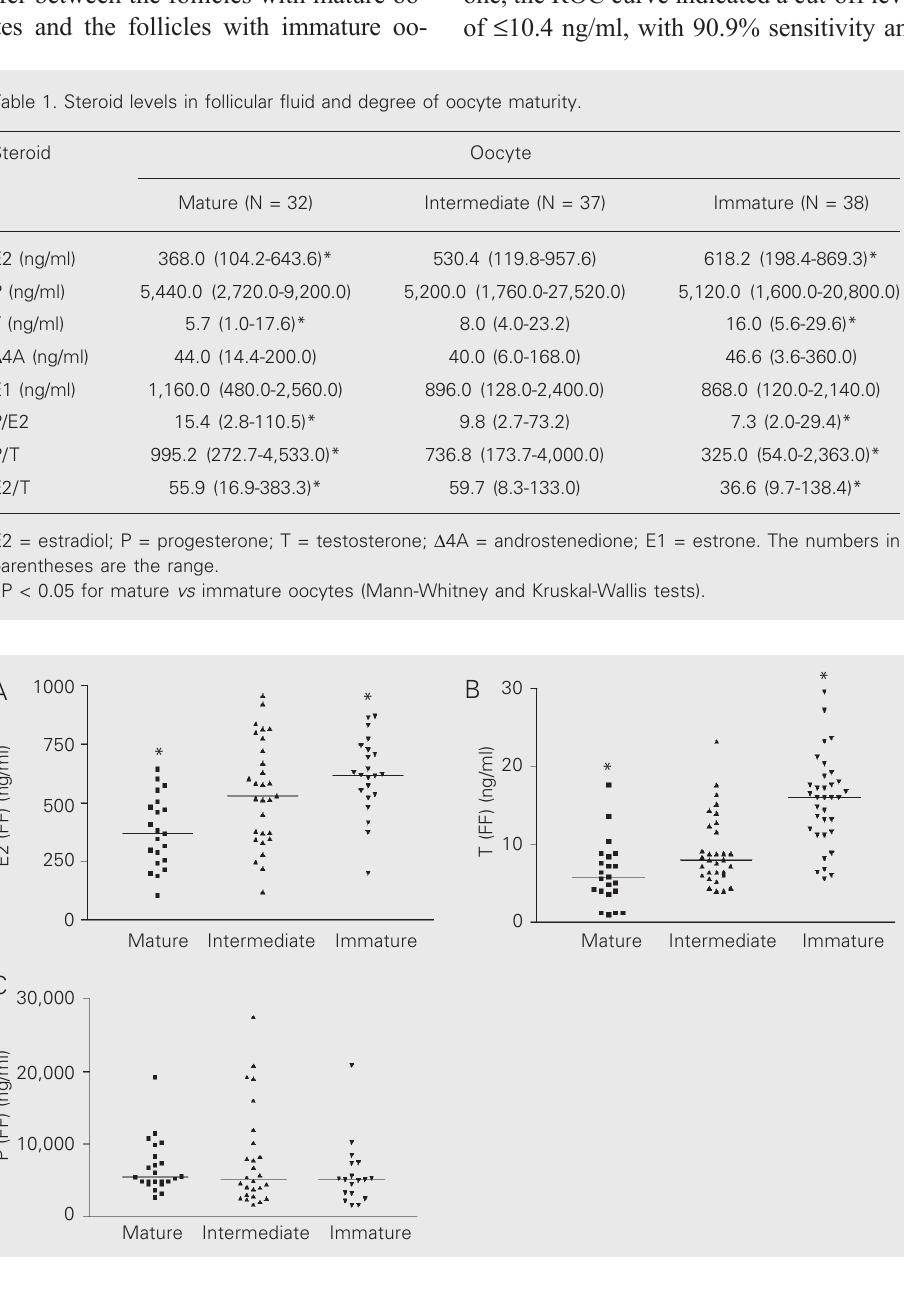
Table 1. Steroid levels in follicular fluid and degree of oocyte maturity.